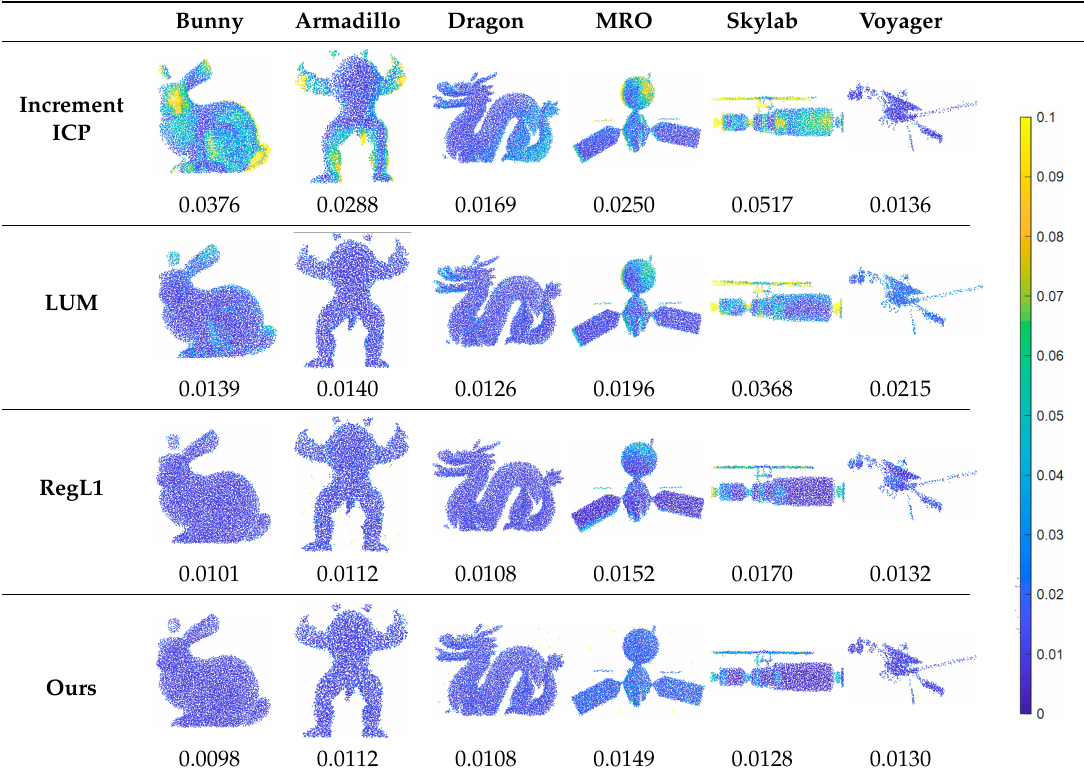
Table 1. The registration result with different methods on simulated point